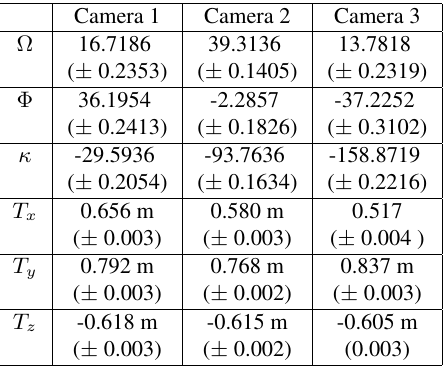
Table 1: Coordinates of each camera in the frame of the calibra- tion sheet. Ω , Φ , κ are the rotation angles, and T x , T y , T z the